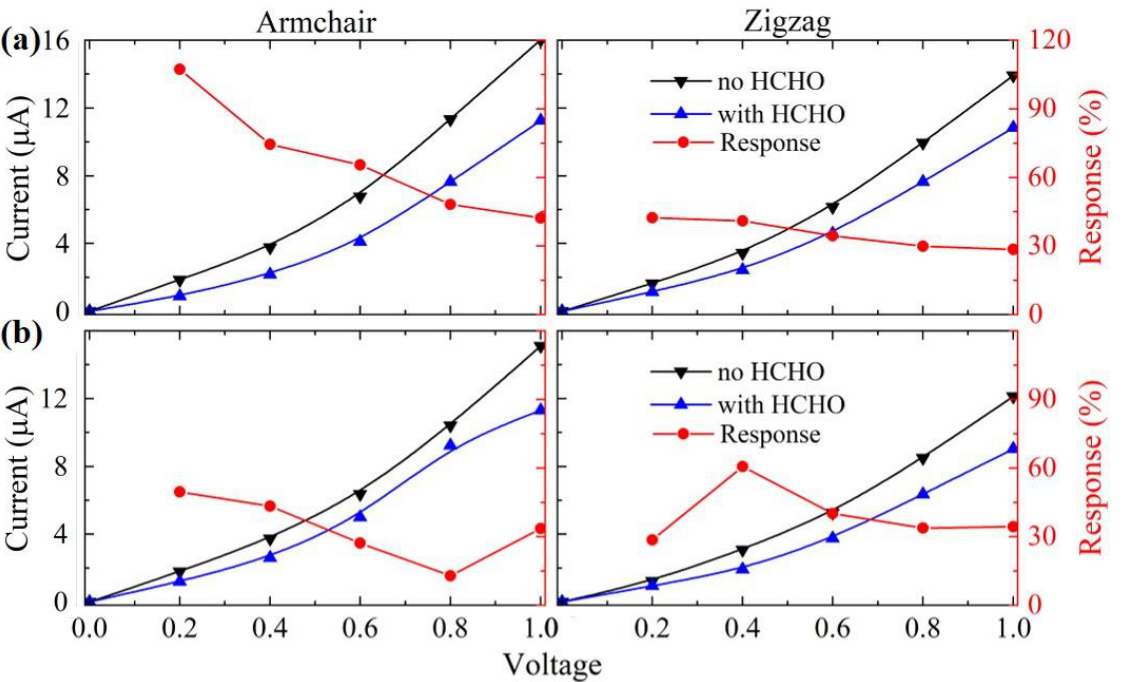
Figure 6. Current-voltage curves and sensing responses of ( a ) Al-doped graphene (AlG) and ( b ) Mg-doped graphene (MgG) nano-sensors without and with HCHO adsorbed. The current flows in the armchair and zigzag direction of the graphene lattice.